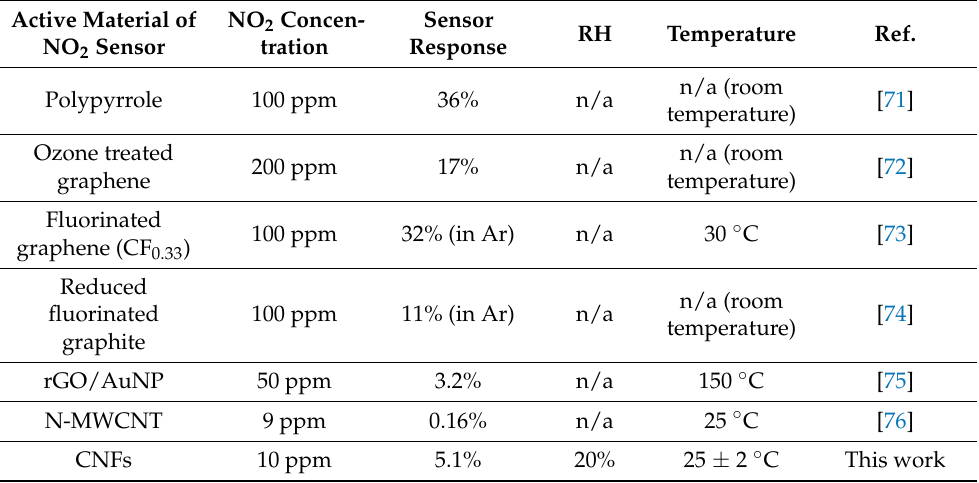
Table 3. Granulated CNF-based NO 2 gas sensor performance compared to the literature data related to different sensor